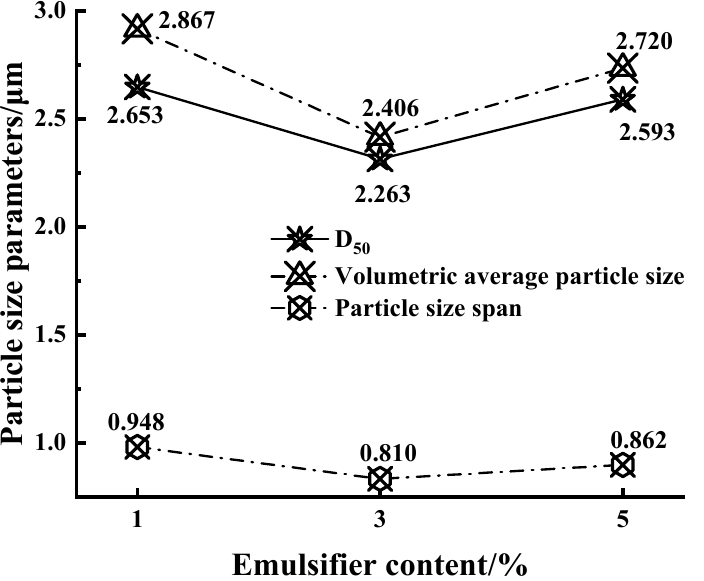
Figure 8. Particle size indexes of bio-oil asphalt/water emulsion with different emulsifier contents. Based on previous studies, it was mostly believed that the average particle size of asphalt/water emulsion particles should be less than 2–4 µ m to achieve better stability performance and permeability [32,33,37]; as shown in Figure 8, the prepared asphalt/water emulsion met the requirements in terms of particle size. However, in contrast, in terms of the D50 and the volume average particle size, it was found that with the increase of the amount of emulsifier, the two particle size indicators showed a trend of firstly decreasing and then increasing, which is consistent with the results of the interaction energy simula- tion, where the thickness of the interfacial layer, with an increasing content of emulsifier, firstly decreased and then increased, and there could be different degrees of thickness of the interfacial film between oil and water to prevent particle aggregation forming larger asphalt/water emulsion particles. In addition, because the emulsifier content was lower, the ionization of the emulsifier molecules on the surface of the particles with a charge, the electrostatic repulsion of the same charge to prevent asphalt particles, and, within a certain range, to increase the amount of emulsifier, could make the asphalt particles increase the charge strength, resulting in electrostatic repulsion also becoming stronger, and the storage stability of the asphalt/water emulsion becoming better. However, when the amount of emulsifier exceeded the critical micelle concentration, the particle size of the asphalt/water emulsion increased with the amount of emulsifier and became larger, because when the concentration of emulsifier reached the critical micelle concentration, the asphalt–water interfacial tension no longer decreased and tended to stabilize, and the emulsifier in addition to the asphalt surface aggregated into a film, the excess emulsifier molecules formed their own lipophilic base inward, and the hydrophilic base formed out- ward multi-molecular aggregates, that is, micelles or micelles. The formation of the average particle size of the emulsion increased. The particle size span reflected the uniformity of particle size distribution of the asphalt/water emulsion, and the sample with 3% emulsifier dosage also had the best uniformity at the same time. From the particle size